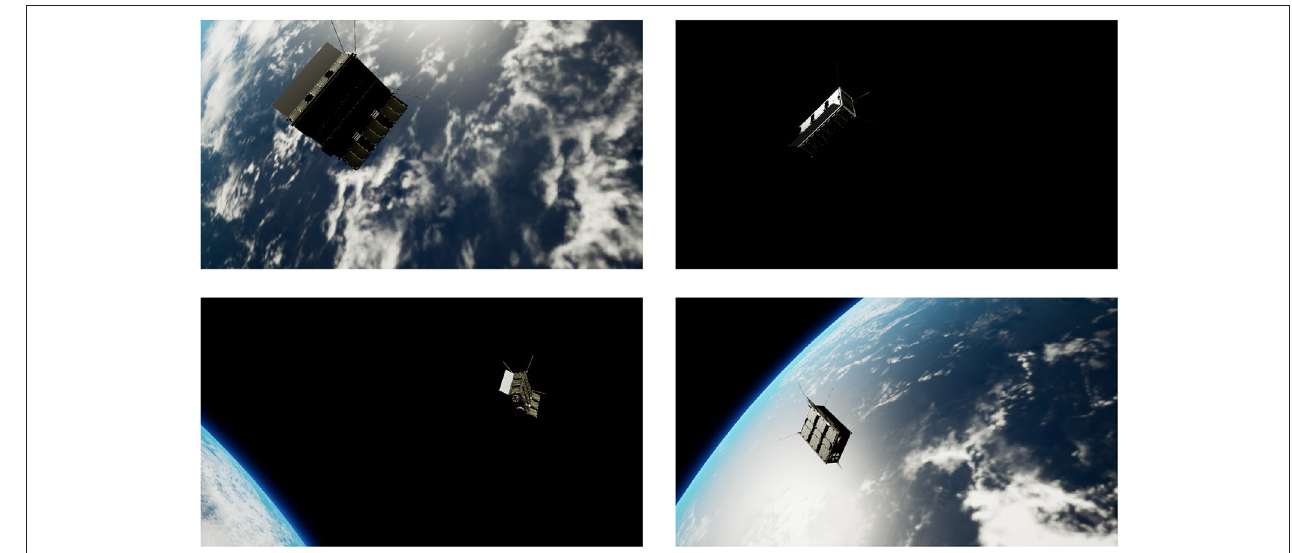
FIGURE 6 | Framework for spacecraft pose estimation using keypoint-based deep learning